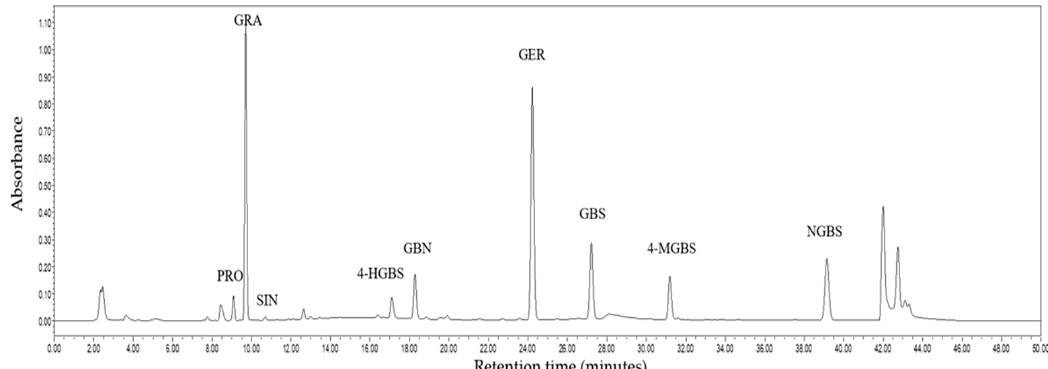
Figure 5. The composition of GSLs in broccoli microgreens. PRO, Progoitrin; GRA, glucoraphanin; SIN, sinigrin; 4-HGBS, 4-hydroxy-glucobrassicin; GBN, glucobrassicanapin; GER, glucoerucin; GBS, glucobrassicin; 4-MGBS, 4-methoxy-glucobrassicin; NGBS, neoglucobrassicin.